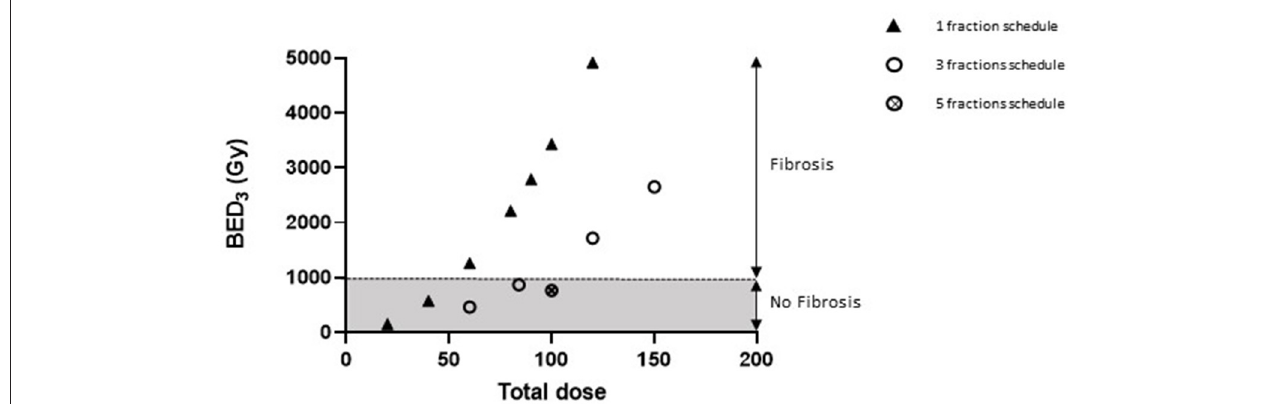
FIGURE 5 | A BED of 1000Gy would be necessary for focal lung fibrosis development. Graphic representing the association between BED values (considering α / β ratio = 3Gy for healthy lung tissue) and lung fibrosis development or otherwise within 6 months of irradiation. Data were obtained after arc therapy using 3 × 3mm beam collimation from this study (three fractions schedules), from Lavigne et al. (23) (90Gy single dose), Soysouvanh et al. (21) (90Gy single dose and 5 × 20Gy schedule), and Bertho et al. ( 12) (20–120Gy single